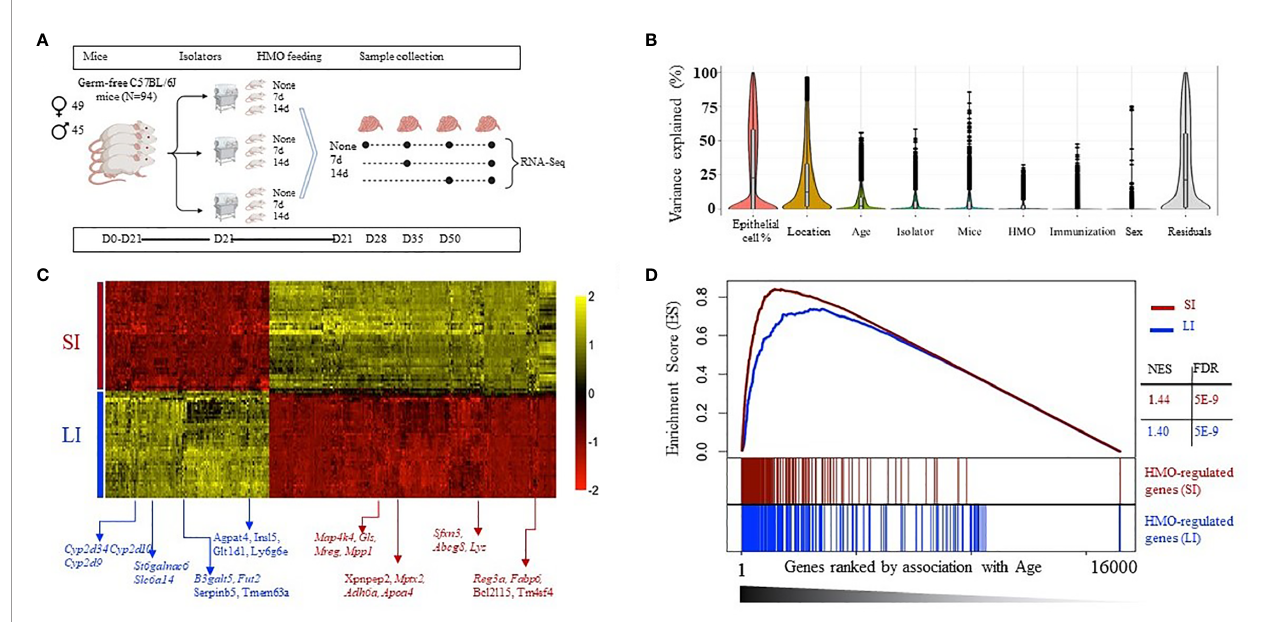
FIGURE 4 | (A) Experimental schema with mice weaned at 21 days of age (n=3 F) and HMO feeding for 7 and 14 days in mice sacri fi ced at 28, 35, and 50 days. Samples collected from SI and large intestine (LI) at each time point were subjected to RNA-seq to determine the effect of HMO feeding and age on overall gene expression patterns. (B) Variance partition analysis using a global model to fi nd out the contribution of each variable to the overall gene expression variance. (C) Heat map of the top 300 genes most associated with the tissue type in multivariate models, showing maximal location-speci fi c expression; (D) Gene enrichment analysis (GSEA) to estimate the degree of overlap between age-induced and HMO-induced expression alterations. Separately in LI and SI samples, genes were ranked based on variance explained due to age (x-axis), and the segment plots (bottom) highlight the position of the top 300 genes most affected by HMO. The vertical axis in line plots (top) represents the cumulative enrichment score (ES) from GSEA analysis, and NES is the overall normalized enrichment score (with FDR = false discovery rate). Groups (conditions): Control germ-free mice (GF) euthanized either at 28 days of age (n= 9; M=5, F=4) or 35 days of age (n= 5; M=3, F=2) or 50 days of age (n = 5; M=1, F=4) respectively; 7d HMOs euthanized at d28 = GF mice that received 100 m l of HMO through 7 consecutive days and euthanized at 28 days of age (n= 5; M=2, F=3); HMO_14d_D35 = GF mice that received 100 m l of HMO through 14 days and euthanized at 35 days of age (n= 6; M=3,